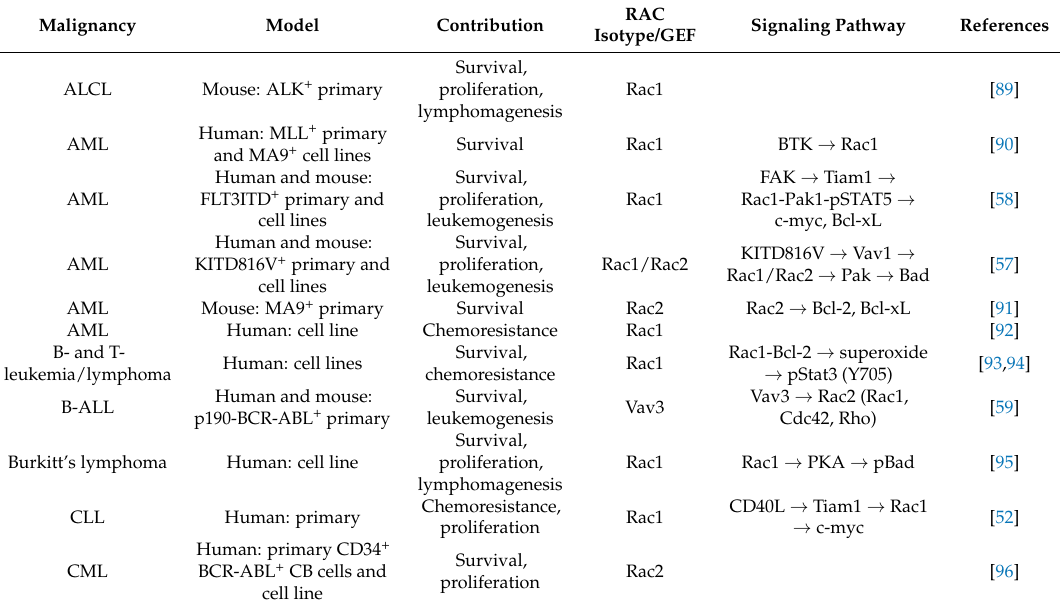
Table 3. Contribution of Rac to leukemic/lymphoma cell survival and chemoresistance.